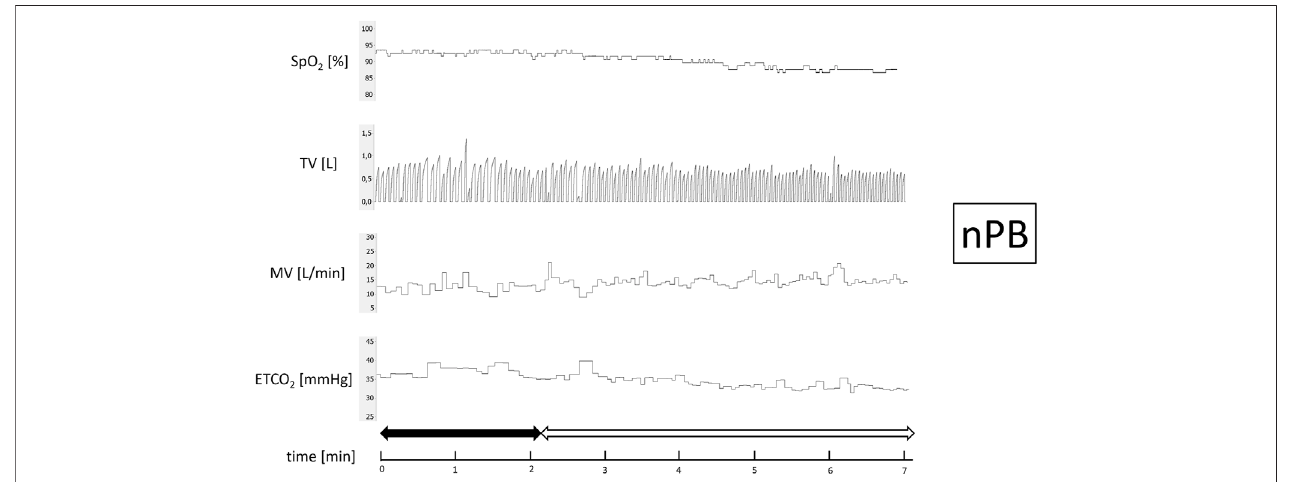
FIGURE 2 | Example of non-inducible periodic breathing (nPB). Continuous recording of oxygen saturation (SpO 2 ), tidal volume (TV), minute ventilation (MV), and end-tidal CO 2 (ETCO 2 ) during induction protocol. Nitrogen titration phase is depicted with solid arrow and fi nal nitrogen fl ow-rate phase with blank arrow.